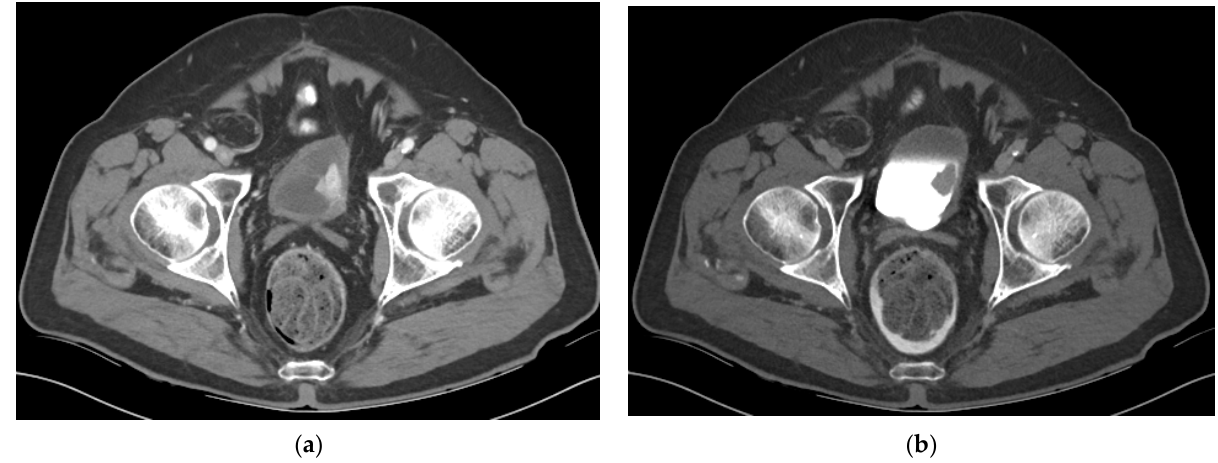
Figure 3. CT of a bladder mass during the urothelial phase and excretory phase ( a ) Axial CT image obtained during the urothelial phase shows a hyperenhancing bladder mass. Bladder tumors tend to be hypervascular and scanning the pelvis during the urothelial phase on CT may aid in tumor evaluation. ( b ) Axial CT image obtained during the excretory phase shows the same mass as a filling defect surrounded by excreted urine in the bladder.